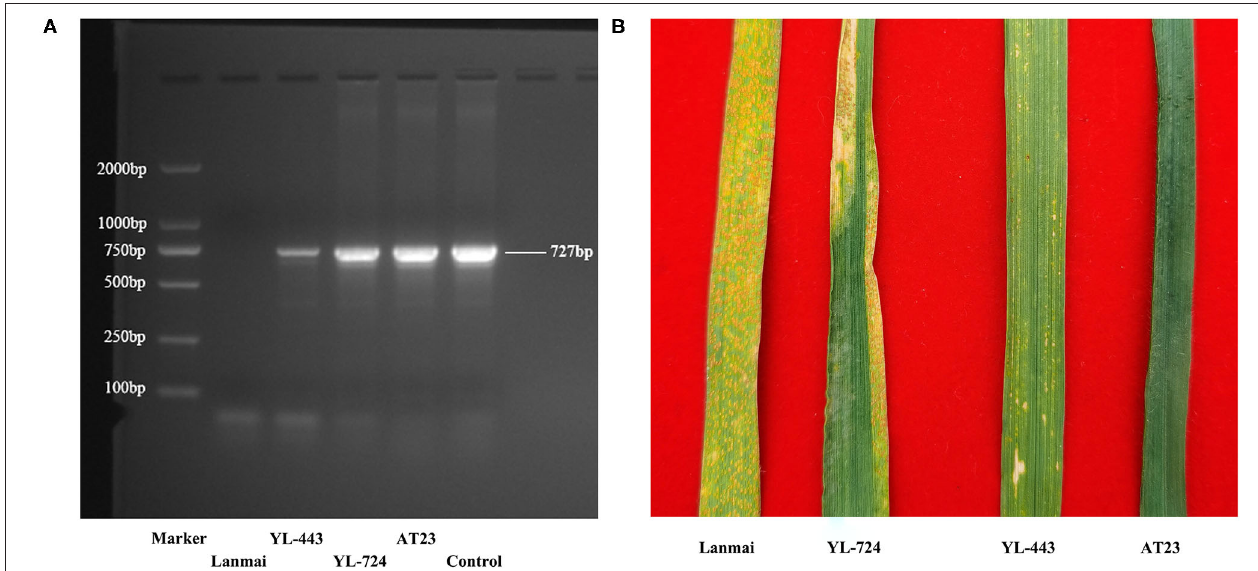
FIGURE 6 | The Yr28 gene amplification results and different APR phenotypes of durum wheat Lanmai, Lanmai/AT23 amphiploid line YL-724, 4D(4B) disomic substitution line YL-443, and Ae. tauschii AT23 for stripe rust. (A) The Yr28 gene amplification results with positve products (727 bp) in all plants except Lanmai. (B) The APR test results of Lanmai (S), YL-724 (MR), YL-443 (HR), and AT23 (I) for stripe rust resistance. I, immune; NI, near immune; HR, high resistance; MR, moderate resistance; MS, moderate susceptibility; S,